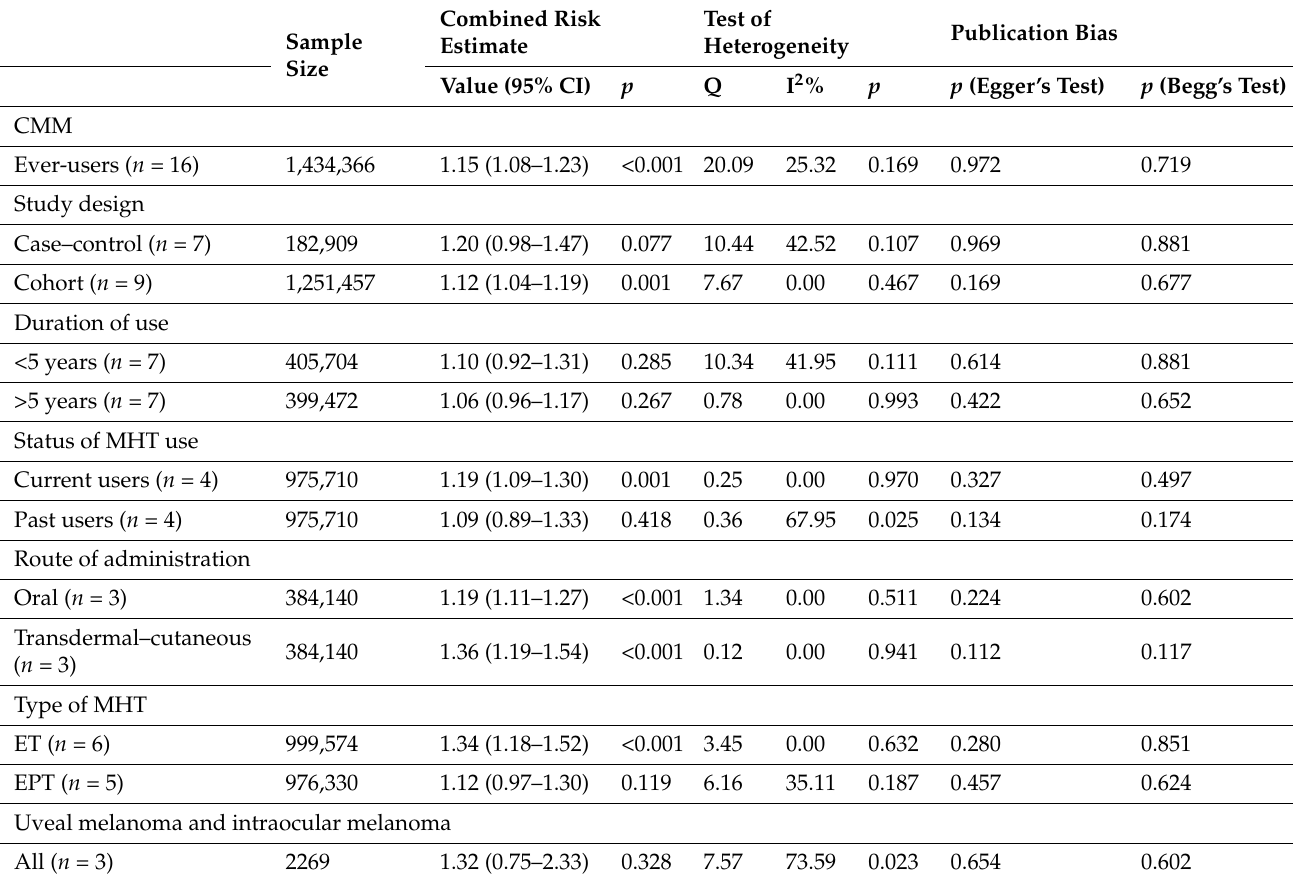
Table 2. Results of stratified analysis of malignant melanoma risk estimates for menopausal hormone therapy (MHT) use. Reference category: no MHT